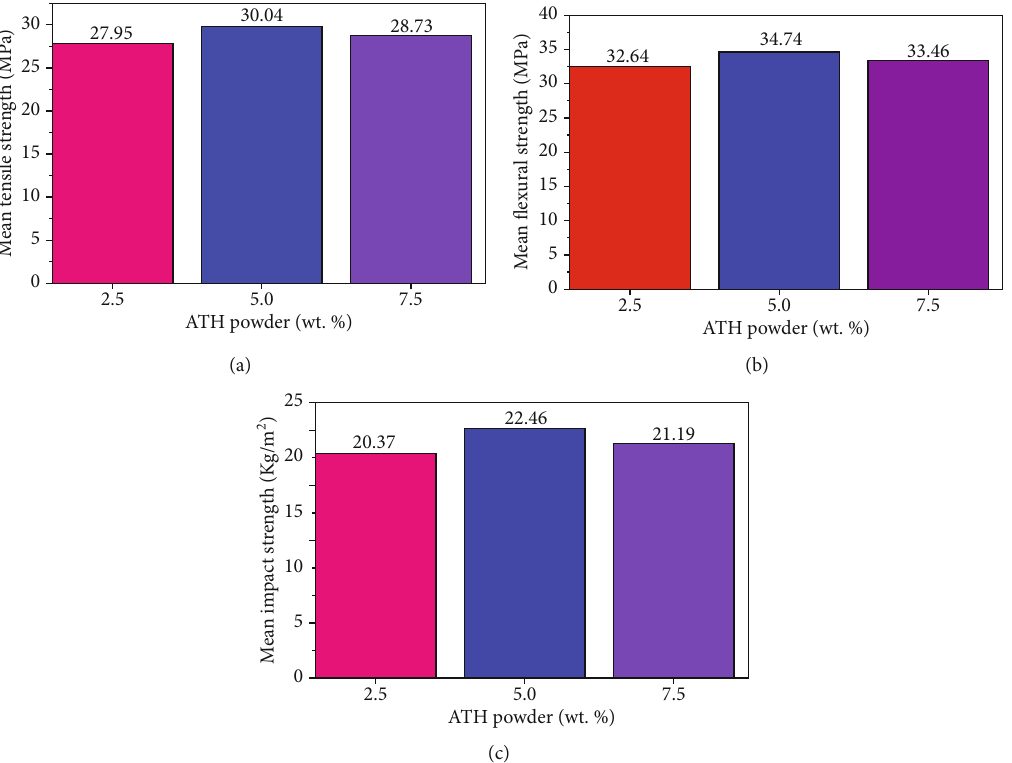
Figure 3: Result of ATH fi ller addition on the mechanical characteristics.